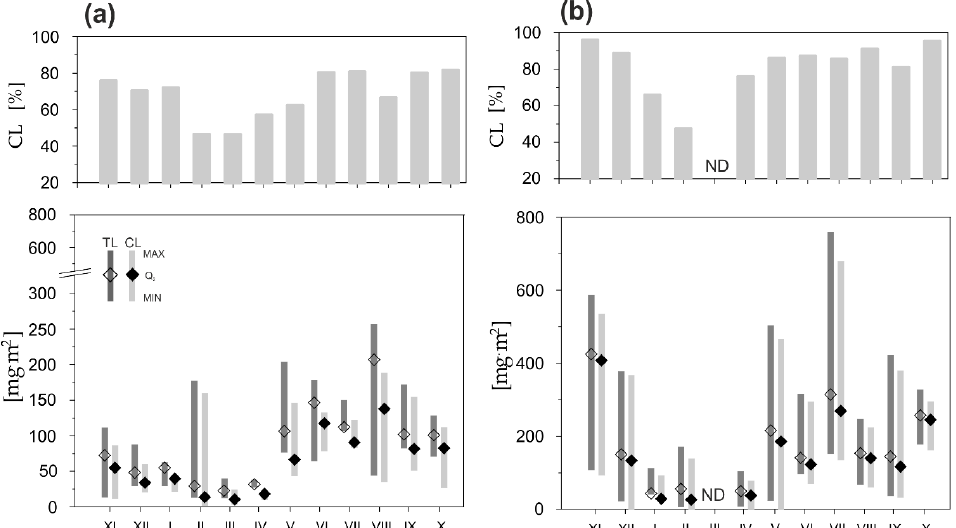
Figure 5. Distribution of total K + load (TL), load leached from the canopy (CL), and load leached from the canopy as a percentage of total K + deposition in Czarne ( a ) and in Malik ( b ). ND—no data, Q 2 — median.